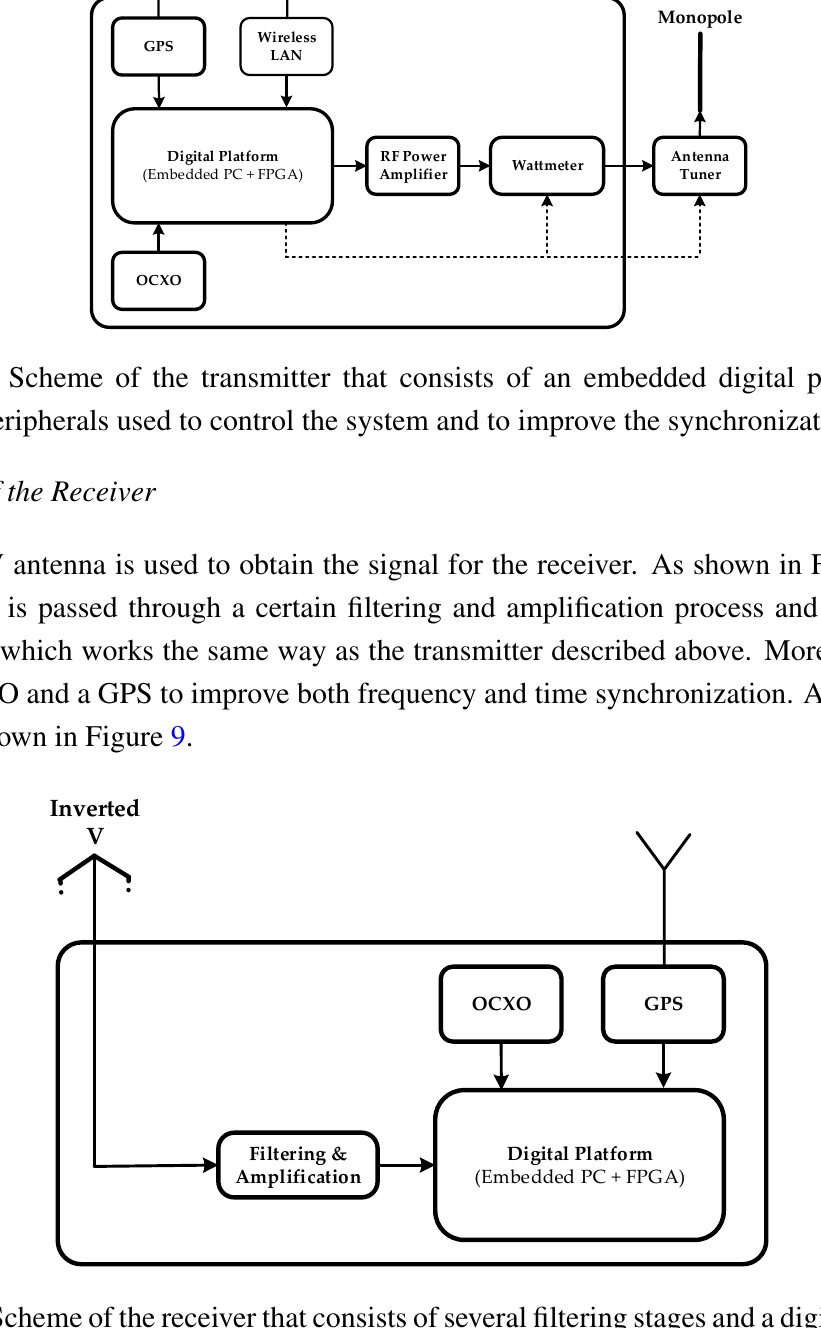
Figure 9. Scheme of the receiver that consists of several filtering stages and a digital platform with peripherals to improve